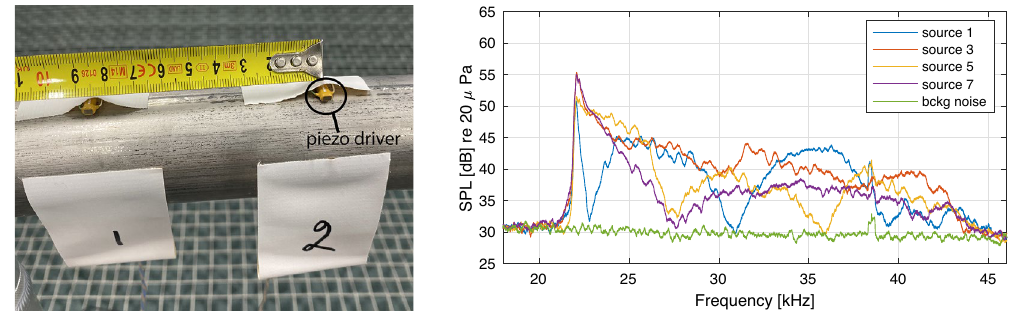
Figure 4. Left: Two piezo drivers of the listening test setup shown in Fig. 2, which were used as ultrasound sources in the test. Right: Frequency spectra of four ultrasonic sources used in the listening test averaged in frequency with 200 Hz wide rectangular